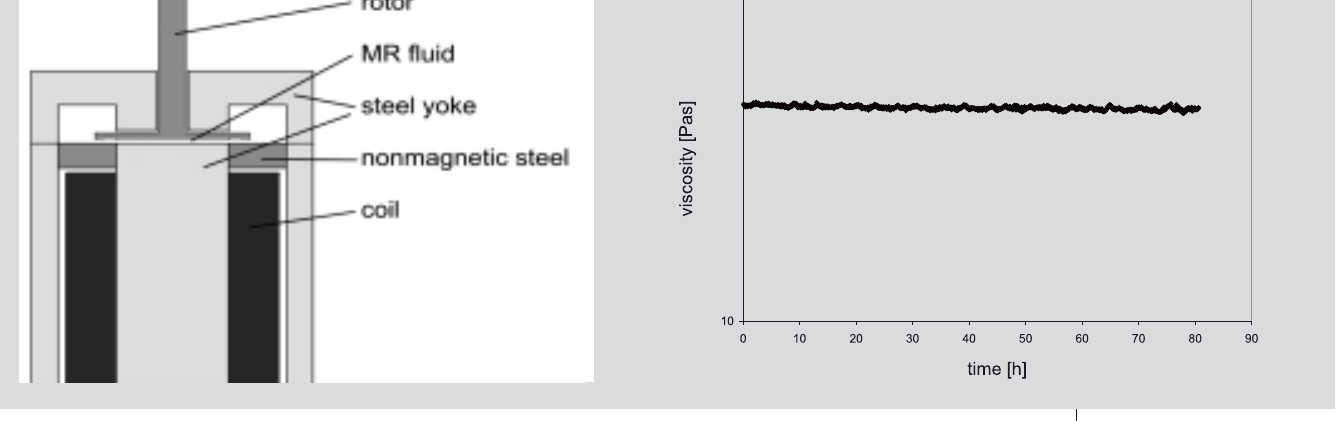
Figure 1 (left): Side view of the parallel plate measuring geometry. Figure 2 (right): Long time stability at 0 T, 343 K, and 1 s -1